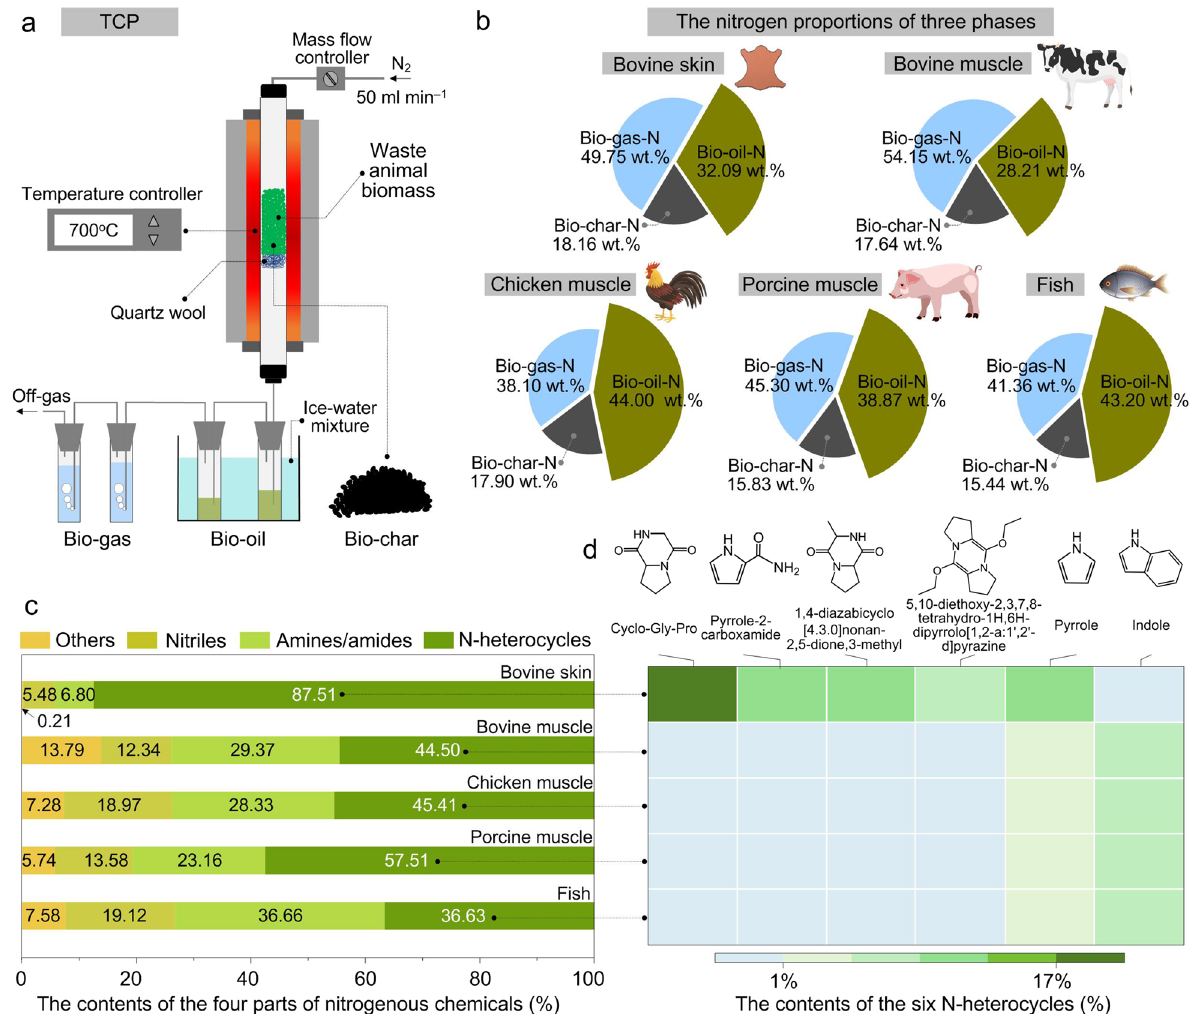
Fig. 2 Analysis of the nitrogenous compounds derived from different animal biomass via TCP. a Schematic illustration of the fixed bed nitrogen-rich thermochemical conversion and collection system of TCP at 700 °C under atmospheric pressure for 30 min. b Nitrogen proportions of three phases products (bio-gas-N, bio-oil-N, and bio-char-N) in total nitrogen of different animal biomass. c The contents of the four parts of nitrogenous compounds (N-heterocycles, amines/amides, nitriles, and others) in all the nitrogenous compounds of bio-oil. d The contents of the six N-heterocycle products in all the nitrogenous compounds of